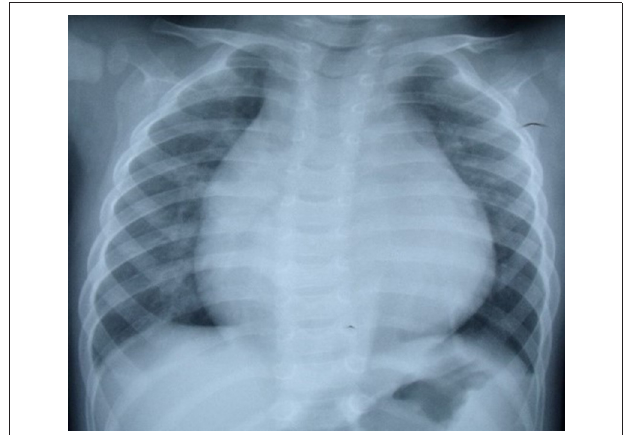
FIGURE 2 | Chest X-ray:cardiac enlargement and cardiothoracic ratio 0.68.